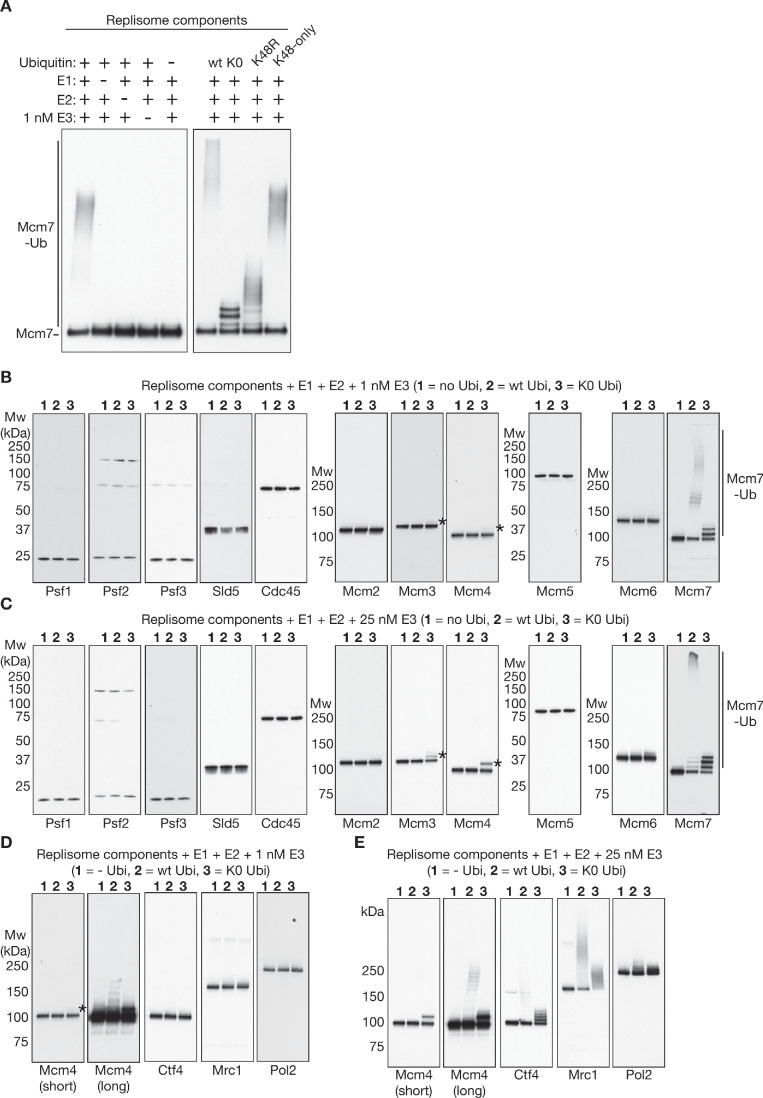
Reconstituted CMG ubiquitylation involves the conjugation of K48-linked ubiquitin chains to Mcm7.(A) Reactions were performed as in Figure 2. The left panel presents the effects of dropping out the indicated components of the reactions. The right panel compares the indicated variants of ubiquitin (‘K0’=lysine free ubiquitin, ‘K48R’ has the indicated single change, whereas all lysines except K48 were mutated to arginine in ‘K48-only’). (B) Ubiquitylation of all 11 CMG components was monitored by immunoblotting under the indicated conditions (1 nM [E3]). (C) Similar reactions were performed in the presence of 25 nM [E3]. (D) Immunoblots of additional replisome components from the experiment in (B), together with longer exposure for Mcm4. (E) Immunoblots of additional replisome components from the experiment in (C).